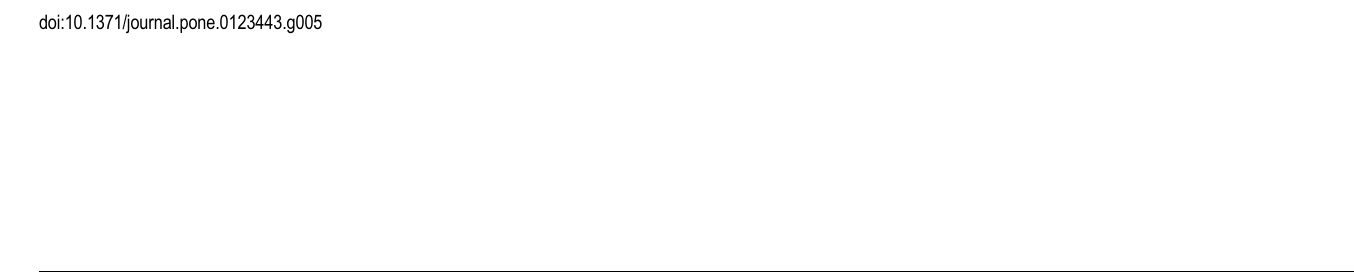
PLOS ONE | DOI:10.1371/journal.pone.0123443 April 9,